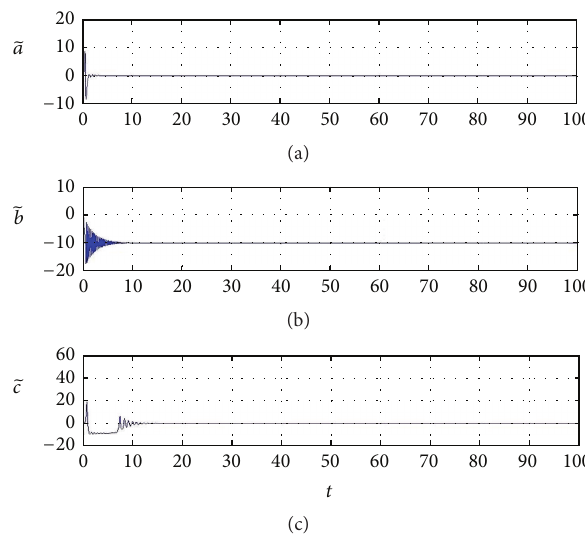
Figure 9: Time histories of parametric errors for master and slave chaotic Lorentz systems.